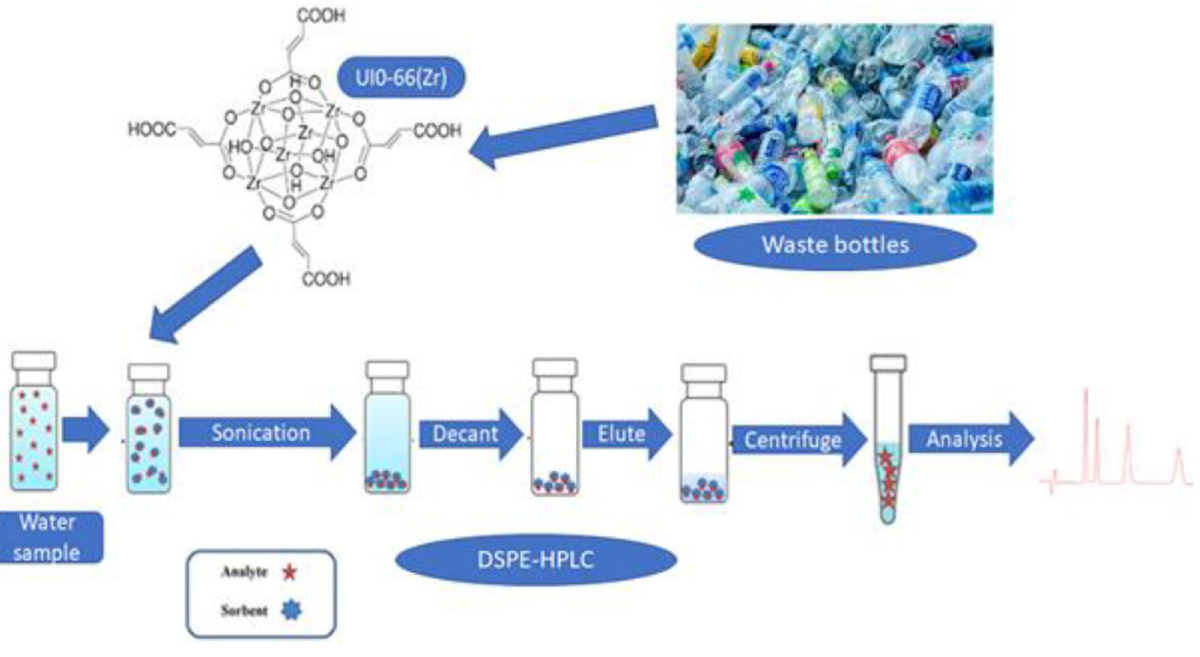
Figure 4. Dispersive solid phase extraction